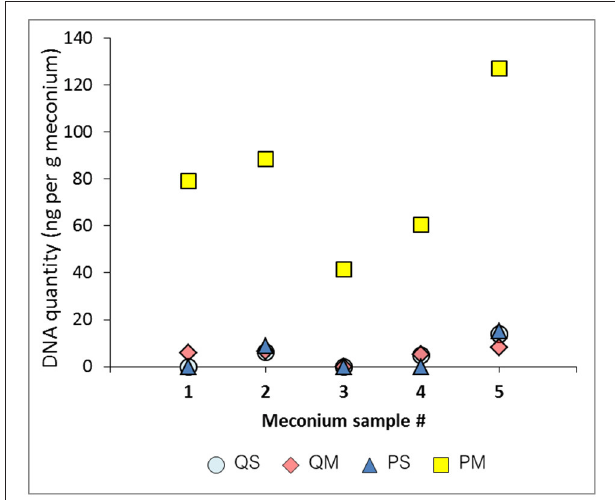
FIGURE 1 | DNA quantitation (ng/g meconium) for each meconium sample using various extraction methods.